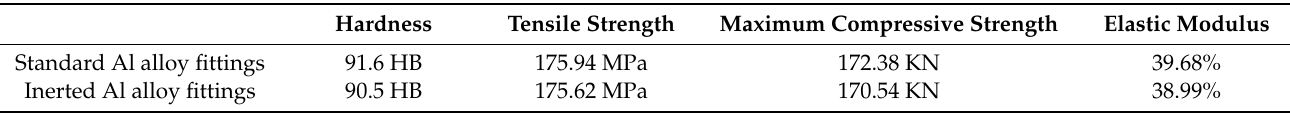
Table 2. Comparison of mechanical properties between standard Al alloy fittings and inerted Al alloy